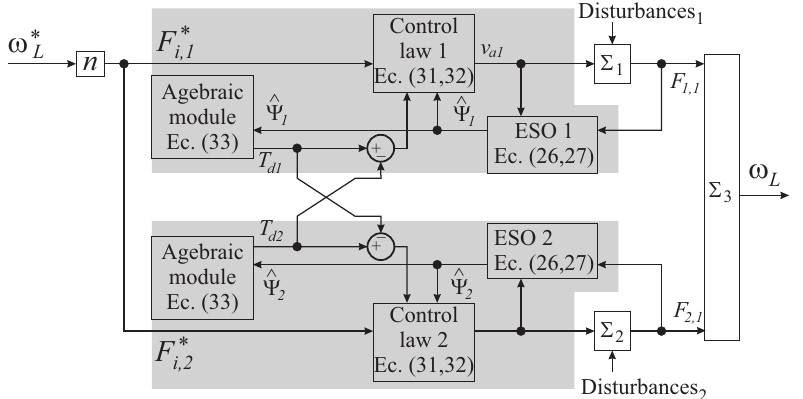
Figure 4. General block diagram of the proposed control